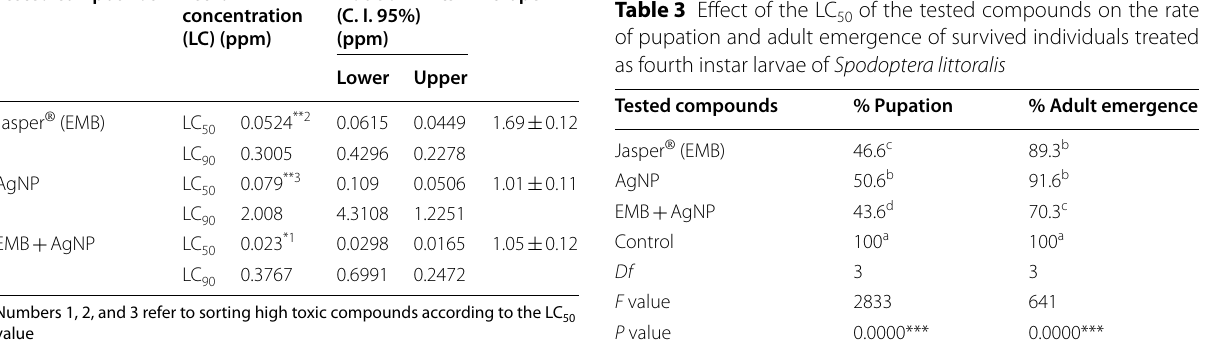
Means followed by the same letter in a column are not significantly different at the 5% level of probability (Duncan’s Multiple Range Test) [14]